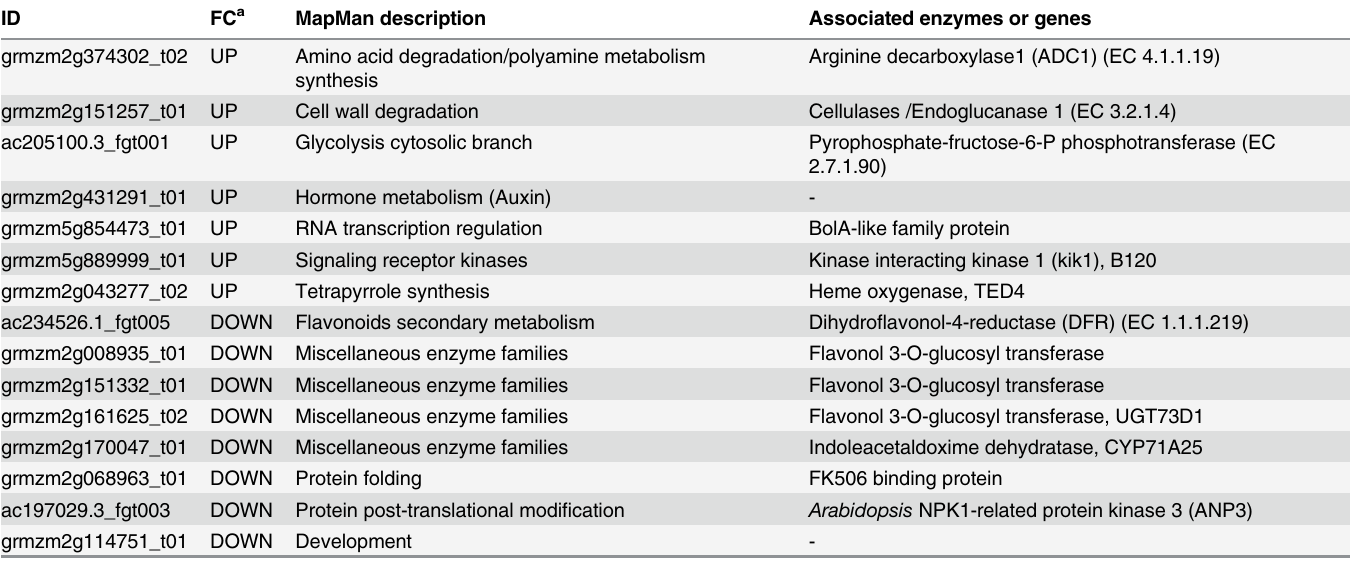
Table 5. The description of common DEGs identified from all pairwise